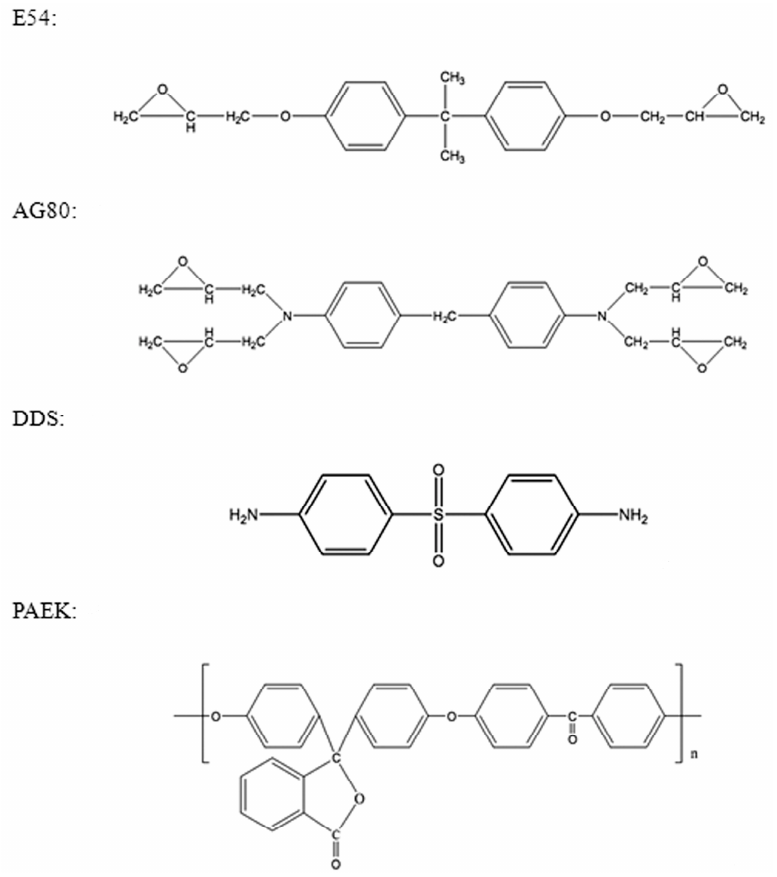
Figure 1. Structures of pristine epoxy resin, curing agent, and toughening agent.